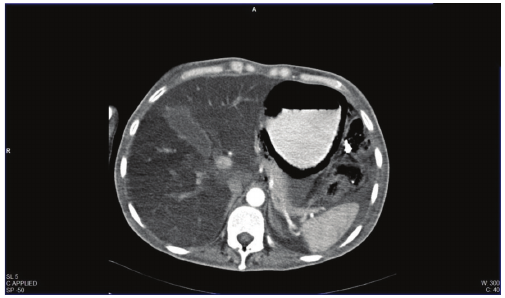
Figure 5: Computed axial tomography of the abdomen with oral and intravenous contrast agent enhancing the stomach during the arterial